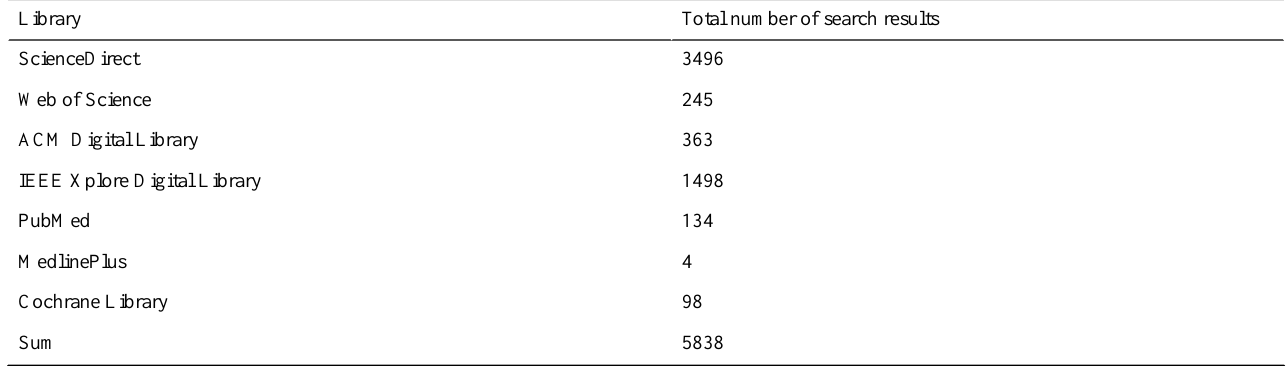
Table 1. Number of search results in the electronic databases.